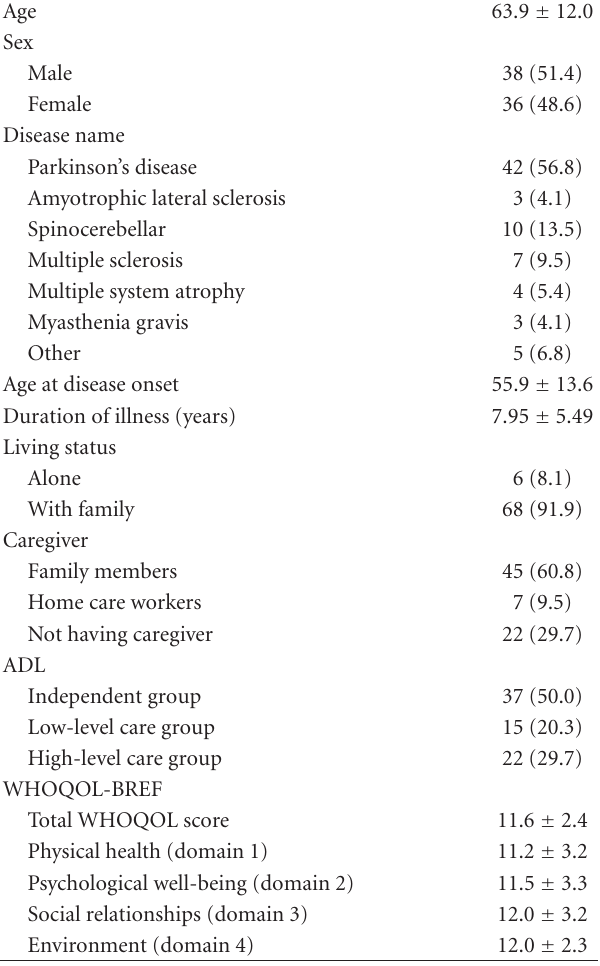
Table 1: Characteristics of patients with intractable neurological diseases ( N =